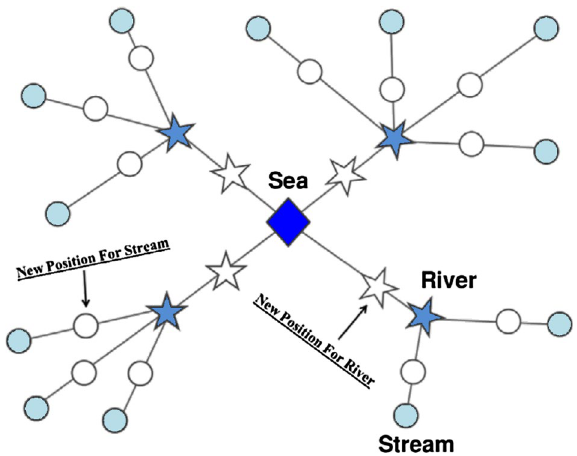
Fig. 2 Schematic view of the used methods in the WCA (Sadollah et al.